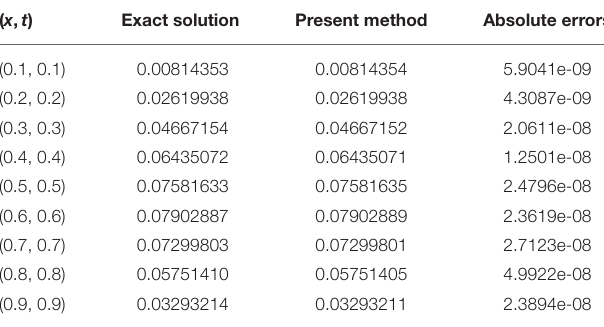
TABLE 2 | Comparison approximate and exact solution at γ = 2 and n = 5, Example 2. ( x , t